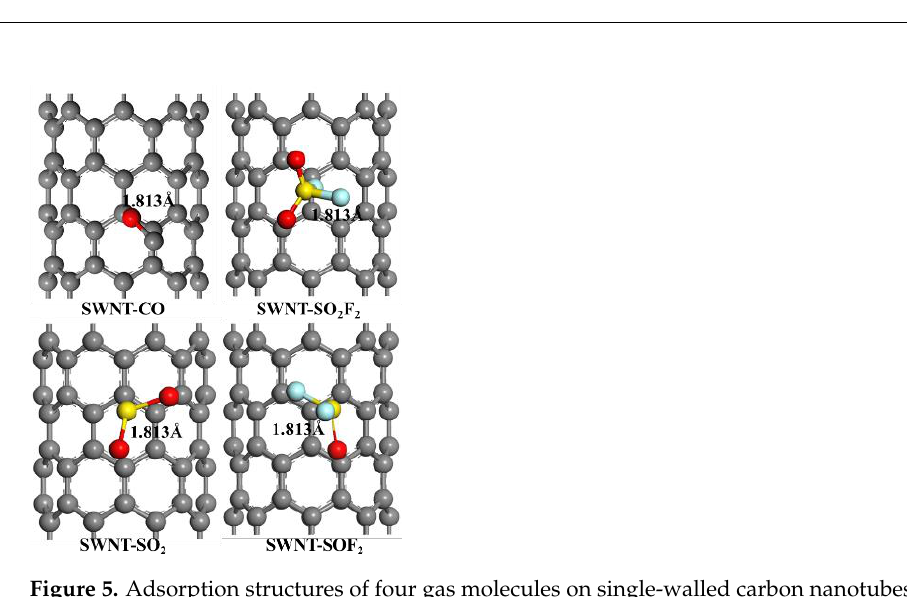
Figure 7. Fitting curve of exponential function corresponding to different CO concentrations. According to the fitting results of the exponential function, the ring-down time corresponding to different concentrations of CO was obtained, and the linear fitting between the concentration and the ring-down time was performed by the least squares method, as shown in Figure 8. It can be seen that there was a good linear relationship between the ring-down time and the gas concentration, with R 2 being 0.984. Figure 8. The relationship between the ring-down time and the gas concentration. Then, after establishing the relationship between gas concentration and ring-down time, to form the quantitative method, the CO gas, with concentrations of 25 ppm, 75 ppm,